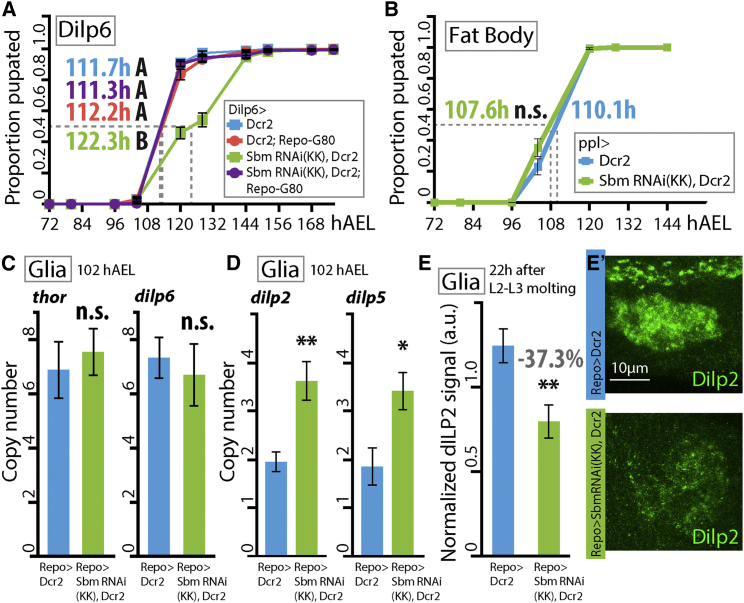
Downregulation of sbm in dilp6-Expressing Glia Partially Reproduces the Developmental Delay Observed without Affecting dilp6 Levels(A) Proportion of larvae pupated through time when overexpressing Dcr2 or SbmRNAi, Dcr2 in dilp6-expressing cells (Dilp6-Gal4) either alone or combined with Repo-Gal80 (one-way ANOVA; data were transformed to the reciprocal values to best fulfill the test criteria, p < 0.0001, F = 15.79; points with different letters signify that they are significantly different [p < 0.05] with Duncan post-test; n = 4–10).(B) Idem A but for downregulation of sbm in the fat body (ppl-Gal4) (t-Test, t = 1.29; n = 4).(C and D) Transcription levels of thor and dilp6 (C) and dilp2 and dilp5 (D) (expressed in copy number) in the brain of 102 hAEL third-instar larvae after downregulation of sbm in all glia (Repo-Gal4) (t test, thor t = 0.57, dilp6 t = 0.54, dilp2 t = 4.25, and dilp5 t = 3.25; ∗p < 0.05; ∗∗p < 0.001; n = 4).(E) Dilp2 immunoreactive signal levels in the somas of insulin-producing cells (IPCs) 22 hr after the second- to third-instar molt in control and Repo > SbmRNAi larvae (t test, t = 3.27; ∗∗p < 0.001; n = 28). The percentage in the graph indicates the difference with respect to controls.(E′) Representative z stack images of each genotype that illustrate the differences in Dilp2 levels.In all graphs, error bars represent SEM and n.s. indicates nonsignificant differences.